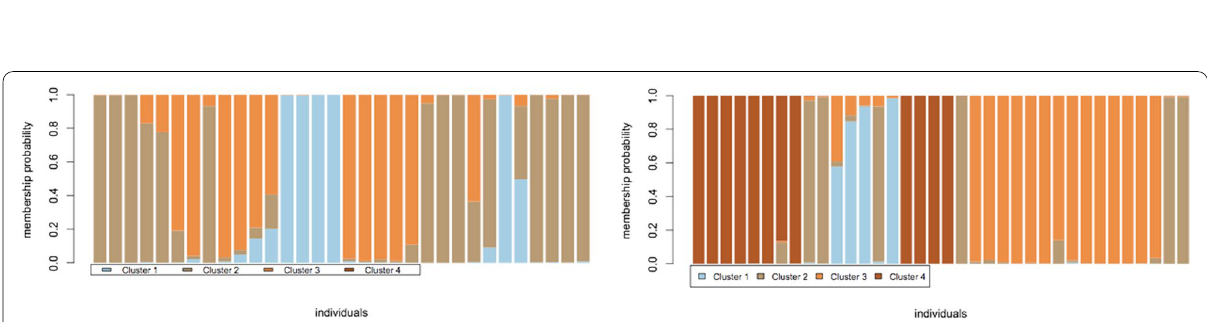
Fig. 4 DAPC diagram of genetic structure of sweet orange cultivars based on SSR data. Number of individuals is based on Table